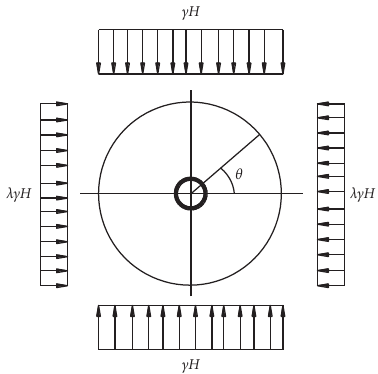
Figure 8: Stress around a hole under inhomogeneous stress